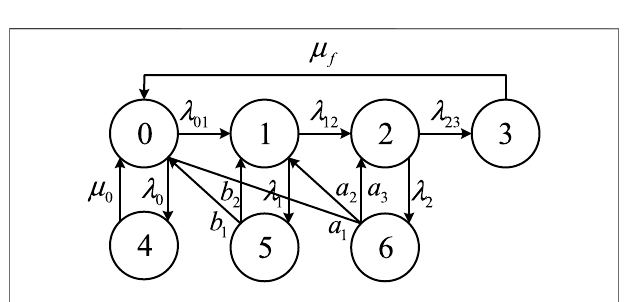
FIGURE 5 | Process of equipment state